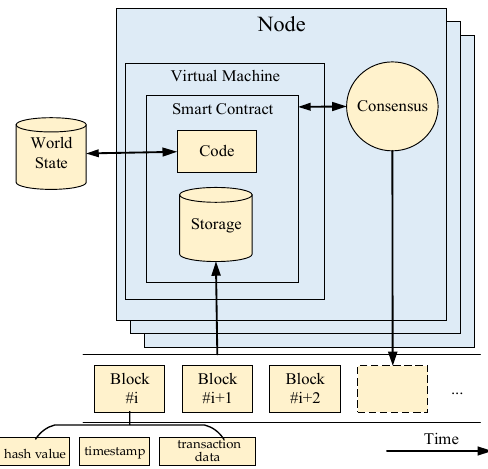
Figure 2. Operation structure of the Ant Blockchain Open Alliance.